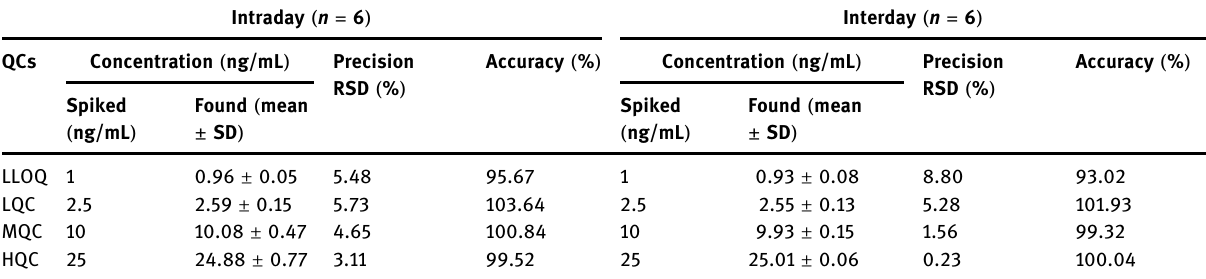
Table 2: Intraday and interday precision and accuracy for the quanti fi cation of SIR in whole blood samples by the LC - MS/MS method ( n = 6